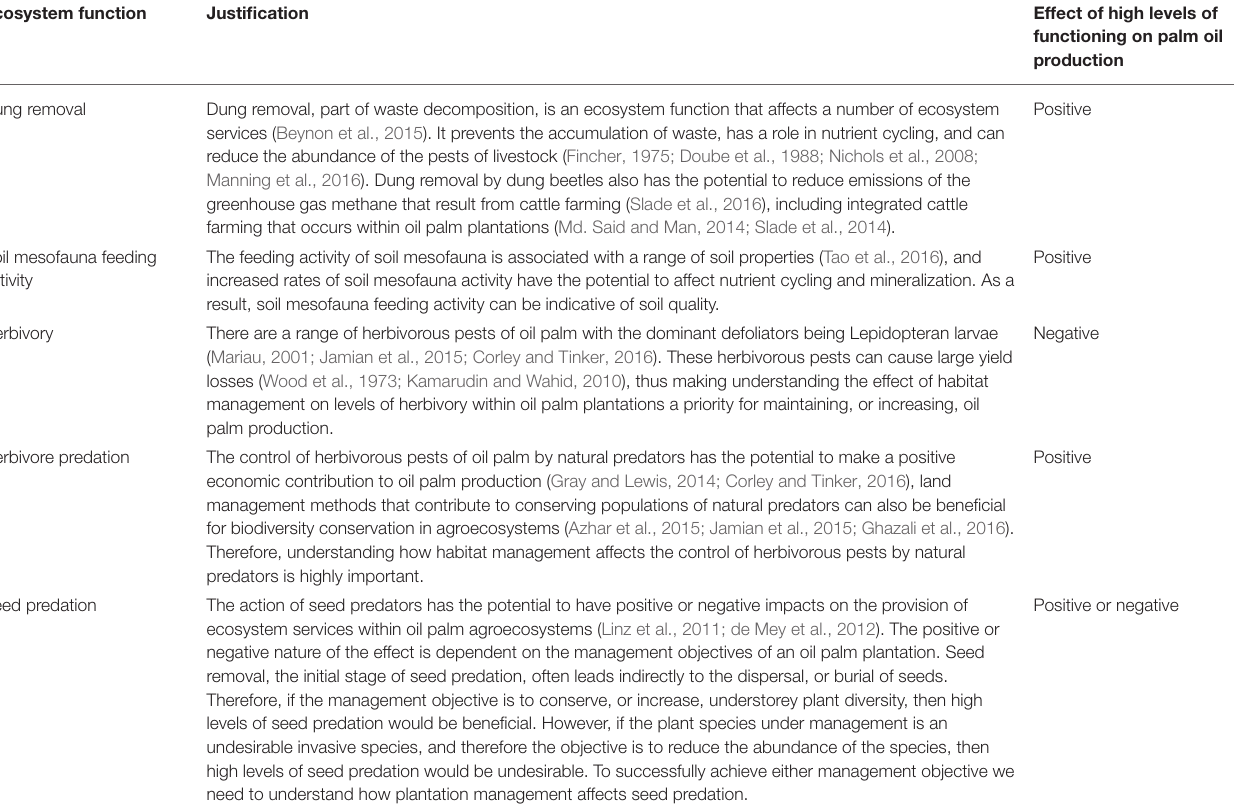
TABLE 1 | Justification of the ecosystem functions measured and their impacts on ecosystem service provision. Ecosystem